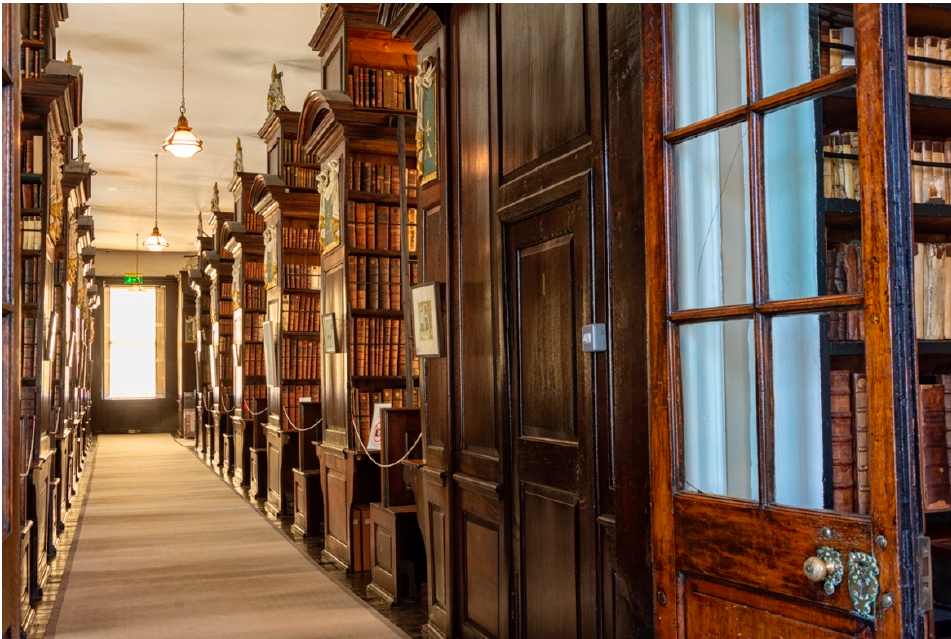
Figure 1. The second gallery of the Library, including Narcissus Marsh’s books. Credit: Phyllis Berger.